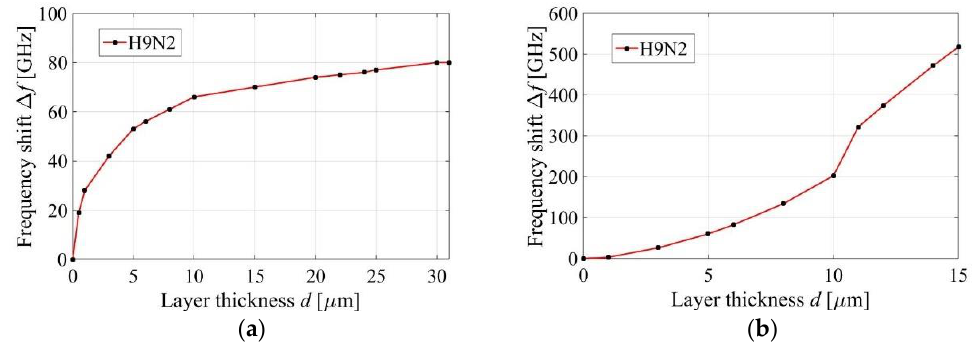
Figure 6. Detection curves for H9N2 around the first absorption peak with Δ f res = 1 GHz for ( a ) SquarePMA and ( b ) CrossPMA.